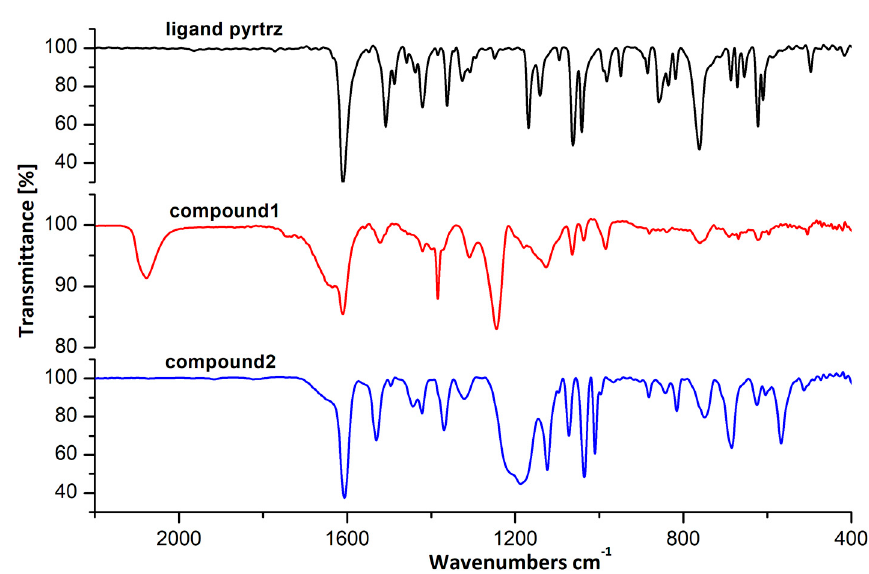
Figure 8. The FT-IR spectra of ligand pyrtrz and compounds 1 , 2 .